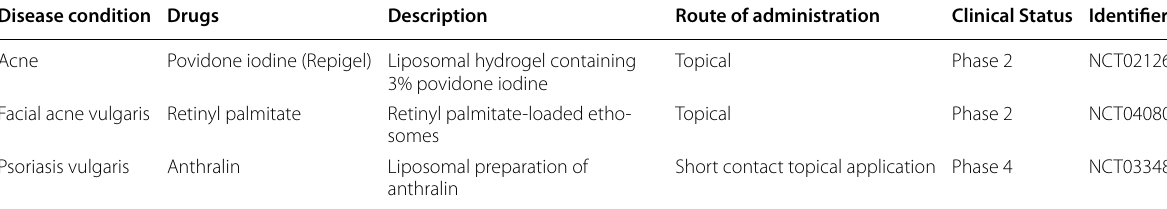
Table 2 Clinical status of liposomes used for cosmeceutical purposes Disease condition